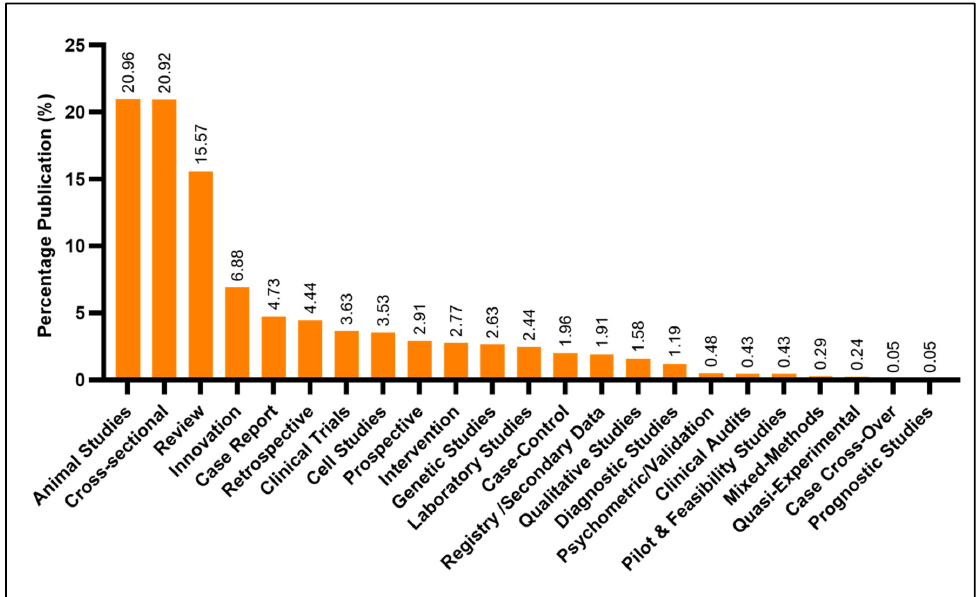
Figure 9. Common study types and designs of diabetes-related research from Malaysia.